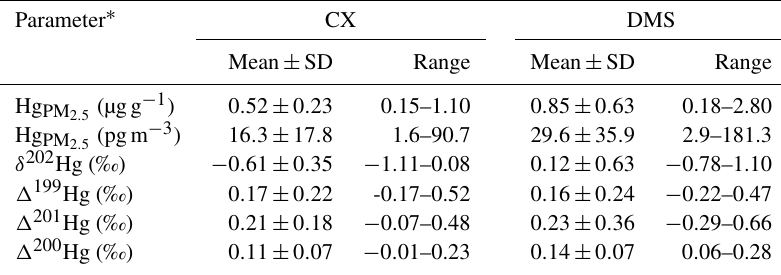
Table 1. Concentrations and isotopic compositions of Hg PM – standard